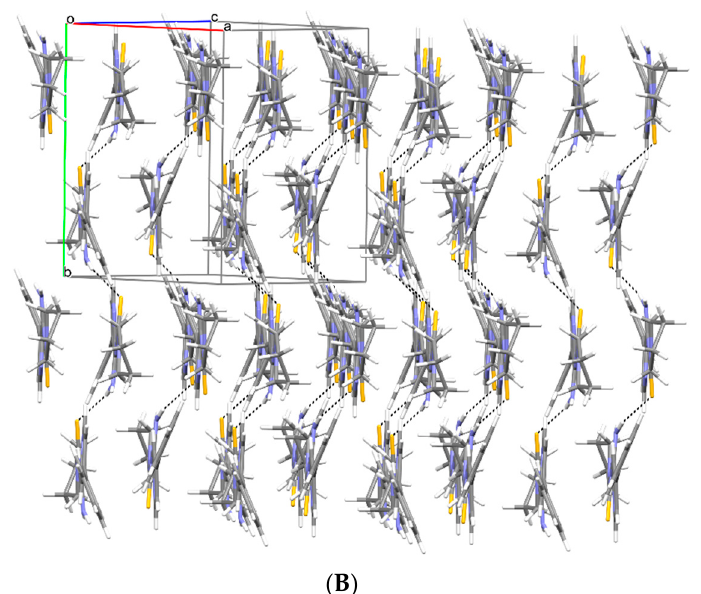
Figure 8. ( A ) Intermolecular hydrogen bonds in 1a . ( B ) The packing of molecules in 1a (a, b, c—unit cell).